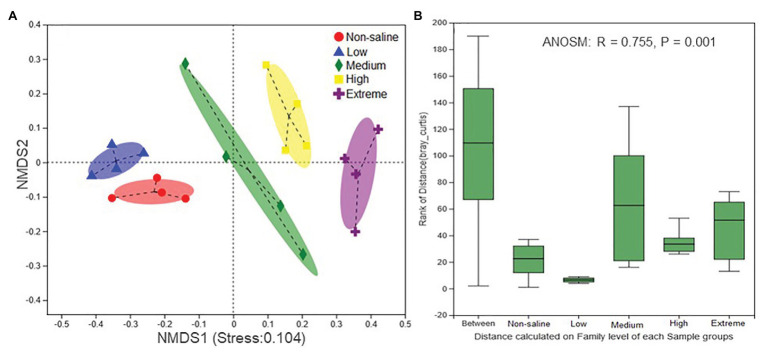
The nonmetric multidimensional scaling (NMDS) ordinations based on the relative abundance of the fungal communities in five different salinized soils (A) and the significant differences between the community structures of each salinity level were evaluated using an analysis of similarities (ANOSIM; B).